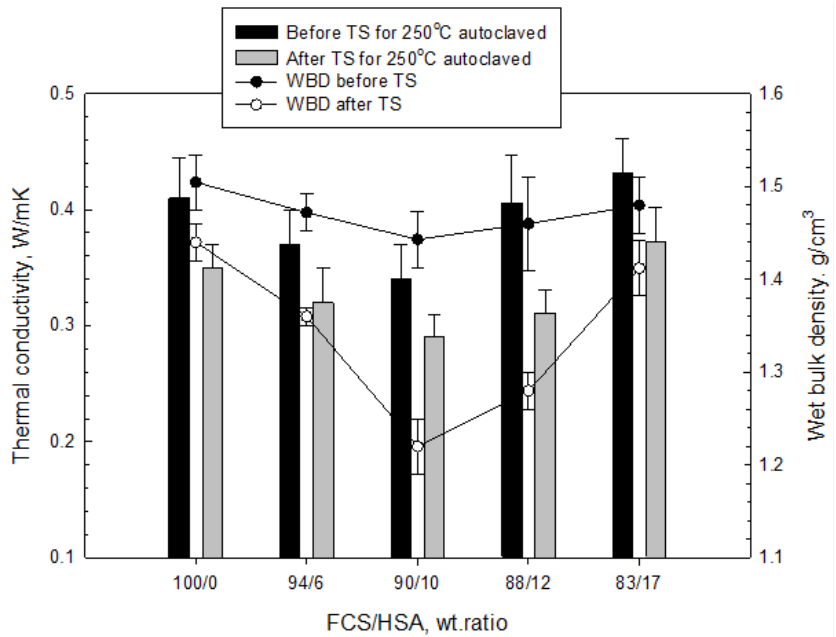
Figure 33. Thermal conductivity and wet bulk density of 250 °C-autoclaved CaP composites made with various FCS/HSA ratios before and after TS.